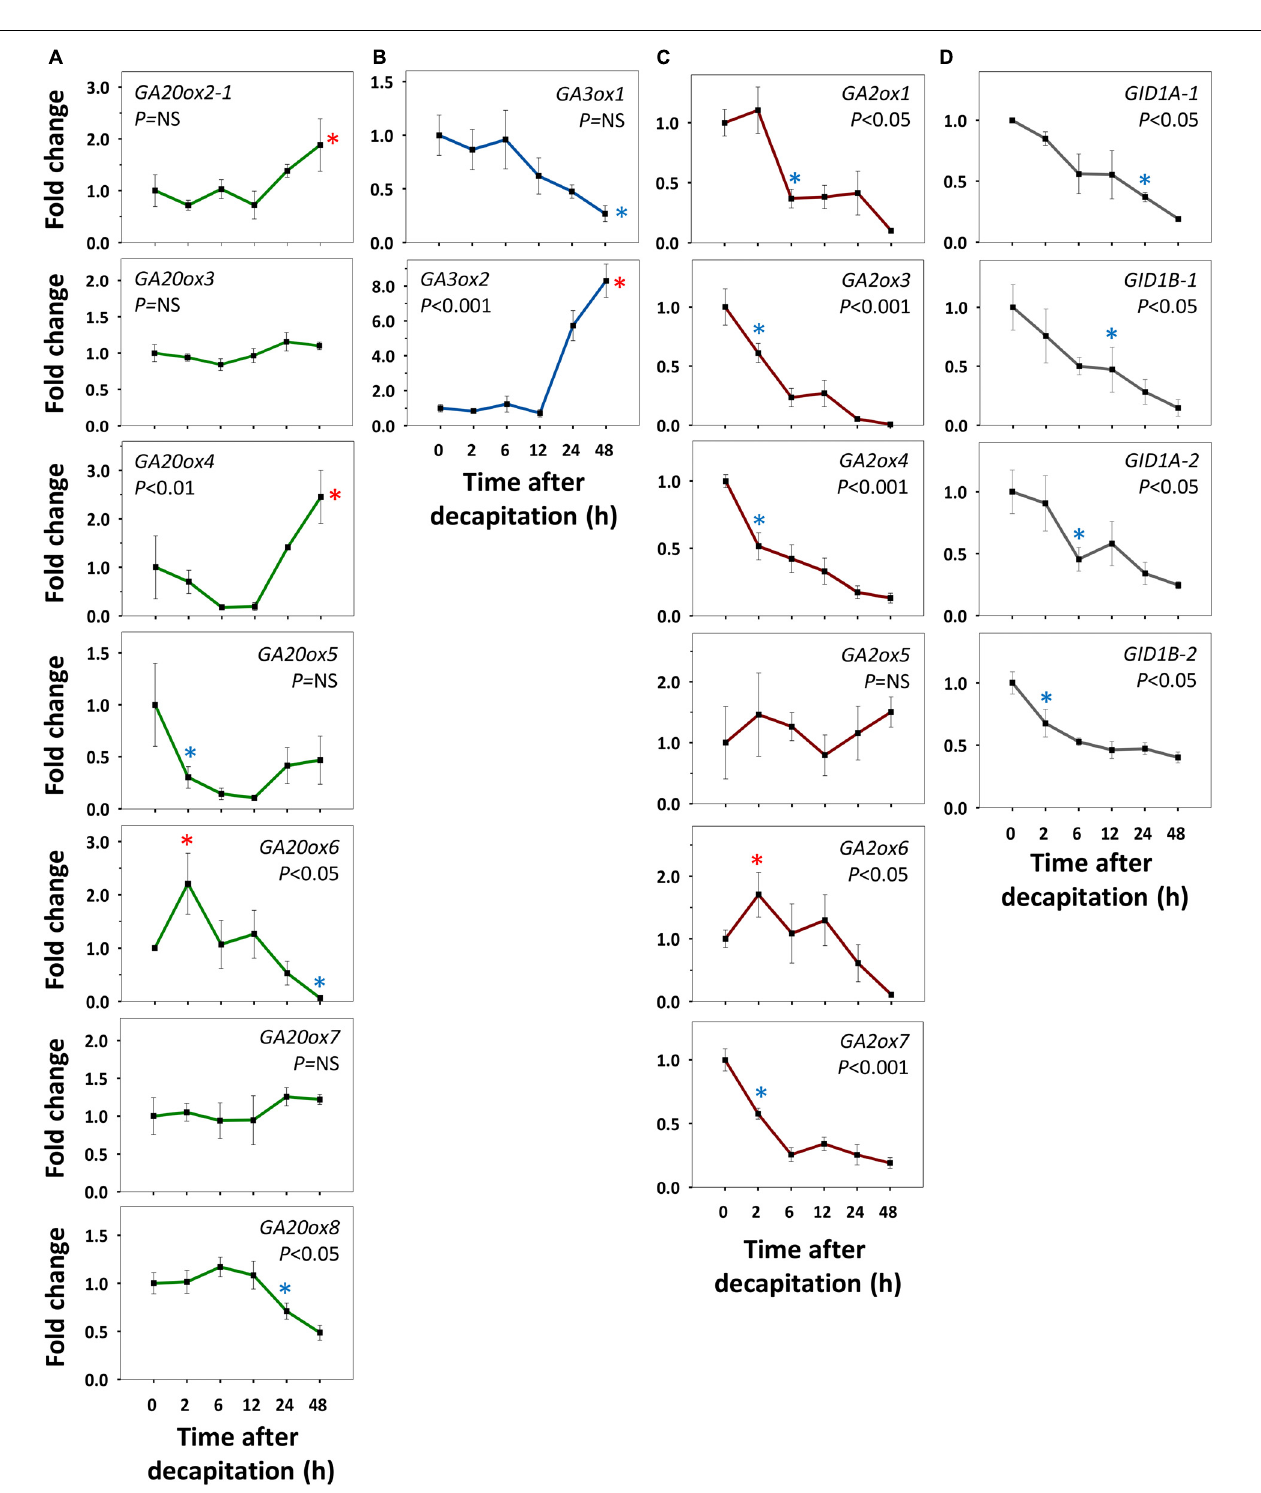
FIGURE 4 | Expression of gibberellin (GA) biosynthesis, deactivation and signaling genes in AXBs after activation by decapitation. (A) GA biosynthesis gene families encoding GA20-oxidases and (B) GA3-oxidases. (C) GA-deactivation gene family encoding GA2-oxidases. (D) GID1-receptor genes. Relative expression (fold change) was analyzed at indicated times after decapitation in three successive AXBs proximal to the decapitation point. Values represent the means of three biological replicates ± S.E. ( n = six plants). One-way ANOVA ( P -value; NS, not significant). Asterisk indicates the first significant decrease (blue) or increase (red), in gene expression in comparison to time 0 (Fischer’s LSD post hoc analysis, P -value at least < 0.05).